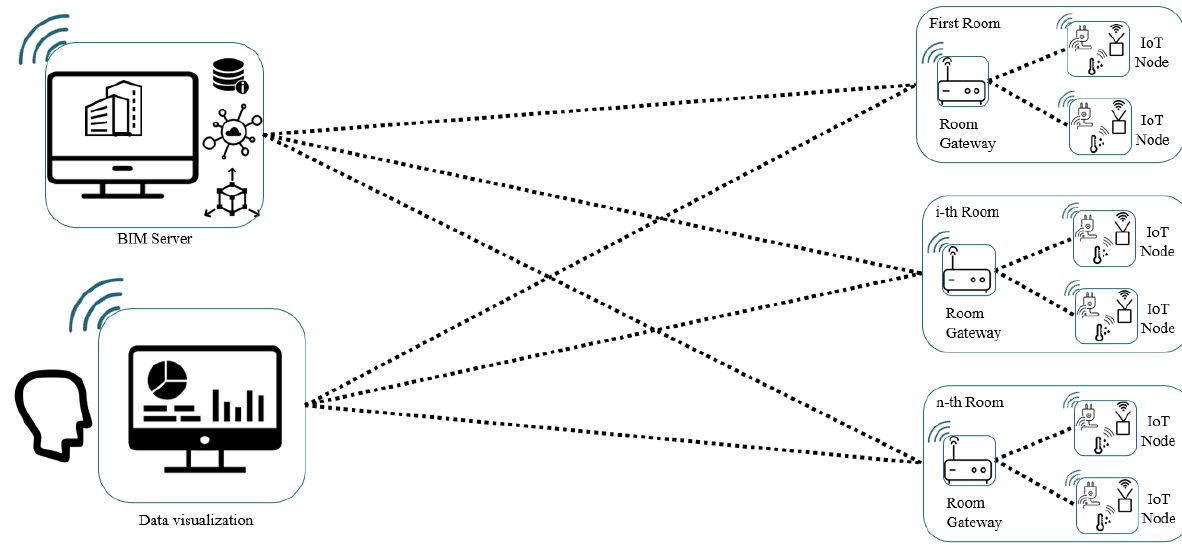
Figure 12. Functional architecture.